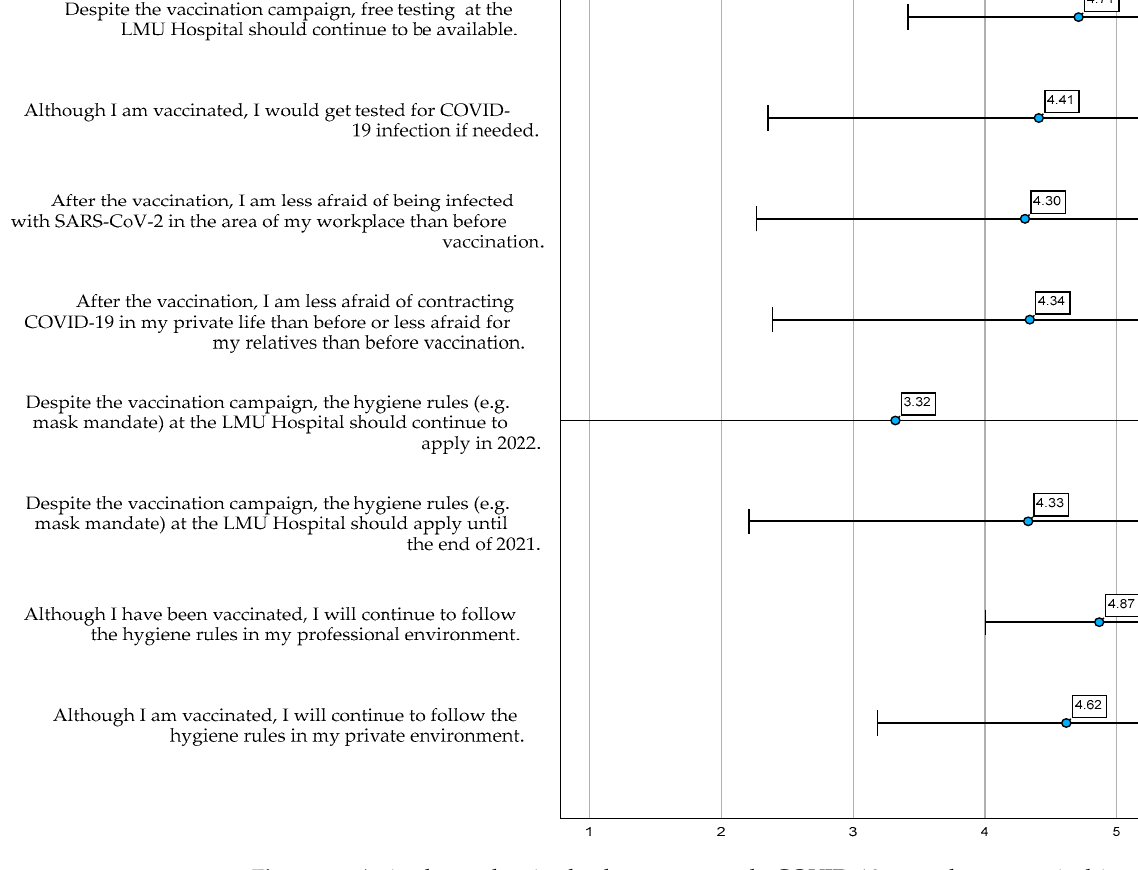
Figure 3. Attitudes and attitude changes towards COVID-19 non-pharmaceutical interventions ( α = 0.687). Mean values, standard deviation of the answers on the five-point Likert scale and Cronbach’s Alpha.